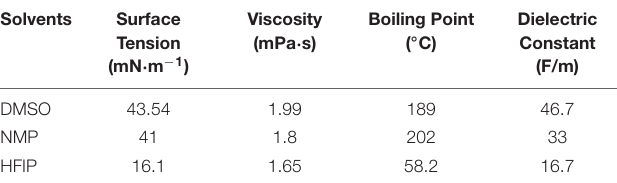
TABLE 3 | Properties of NMP, DMSO, and